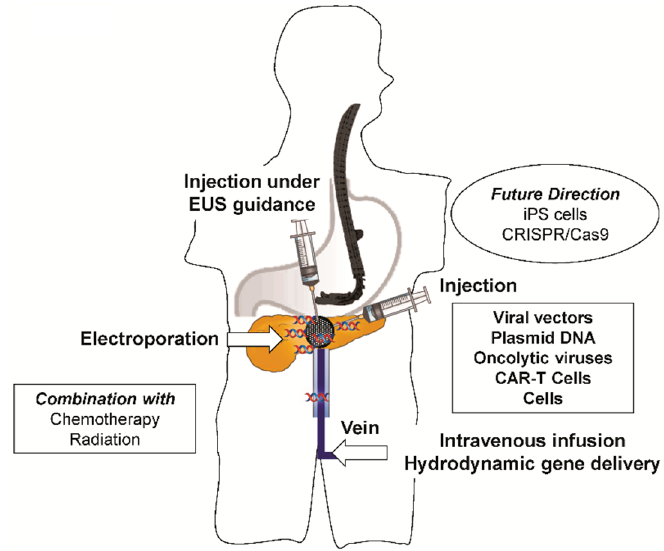
Figure 1. Schematic summary of the strategies of gene therapy for the pancreas. EUS, endoscopic ultrasound; iPS cells, inducible pluripotent stem cells; CRISPR/Cas9, clustered regularly interspaced short palindromic repeats/CRISPR associated protein 9; CAR-T, chimeric antigen receptor-T cell; DNA, deoxyribonucleic acid.